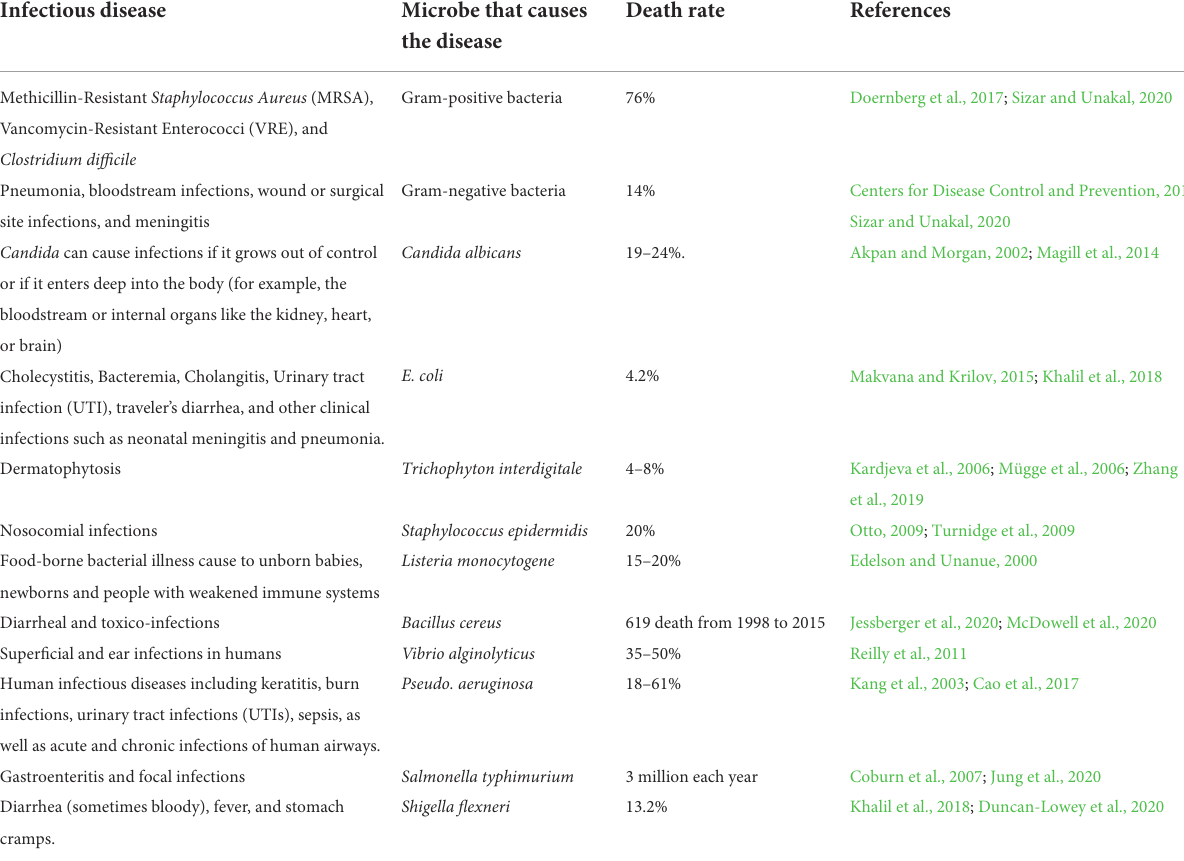
TABLE 3 Infectious diseases caused by